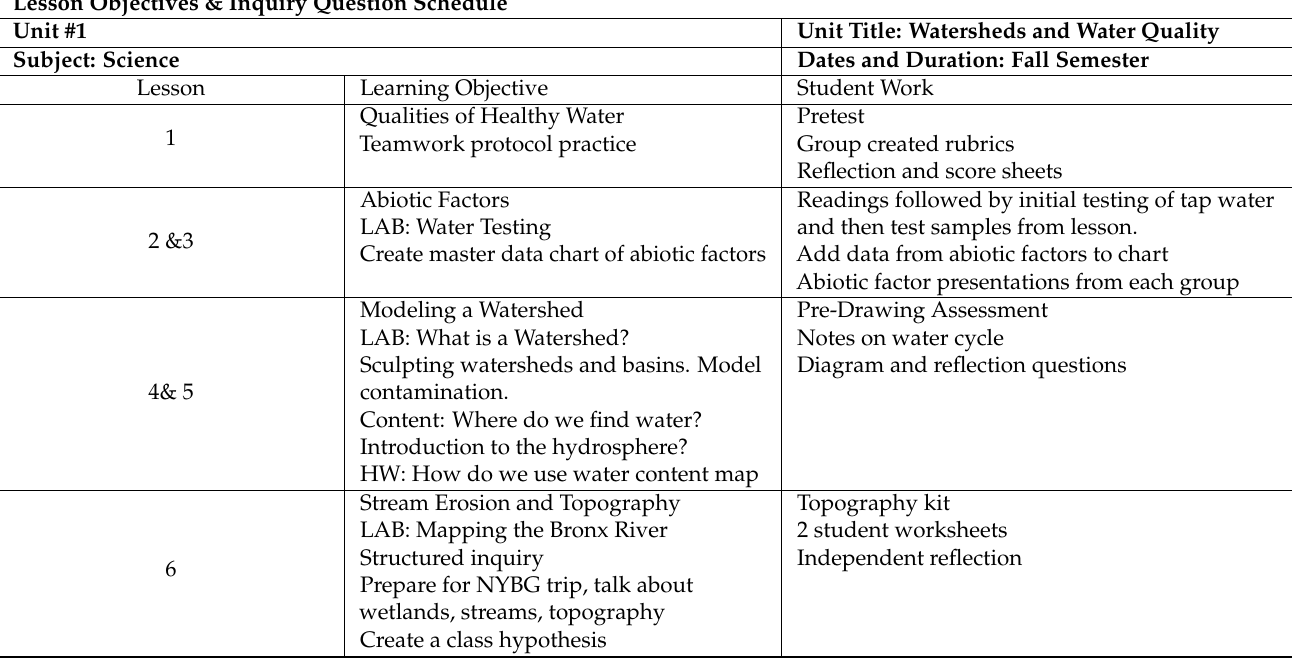
Table A2. Learning Objective and Unit Question